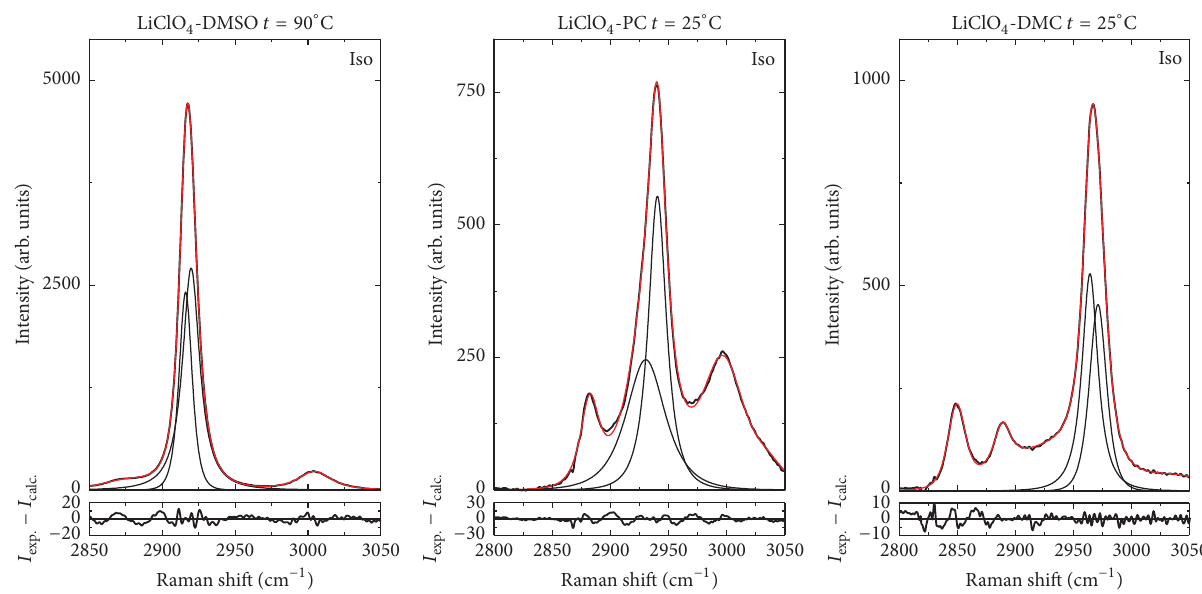
Figure 2: Raman spectra of DMSO, PC, and DMC solutions containing 0.15 mole fractions of LiClO 4 in the region sensitive to anion solvation